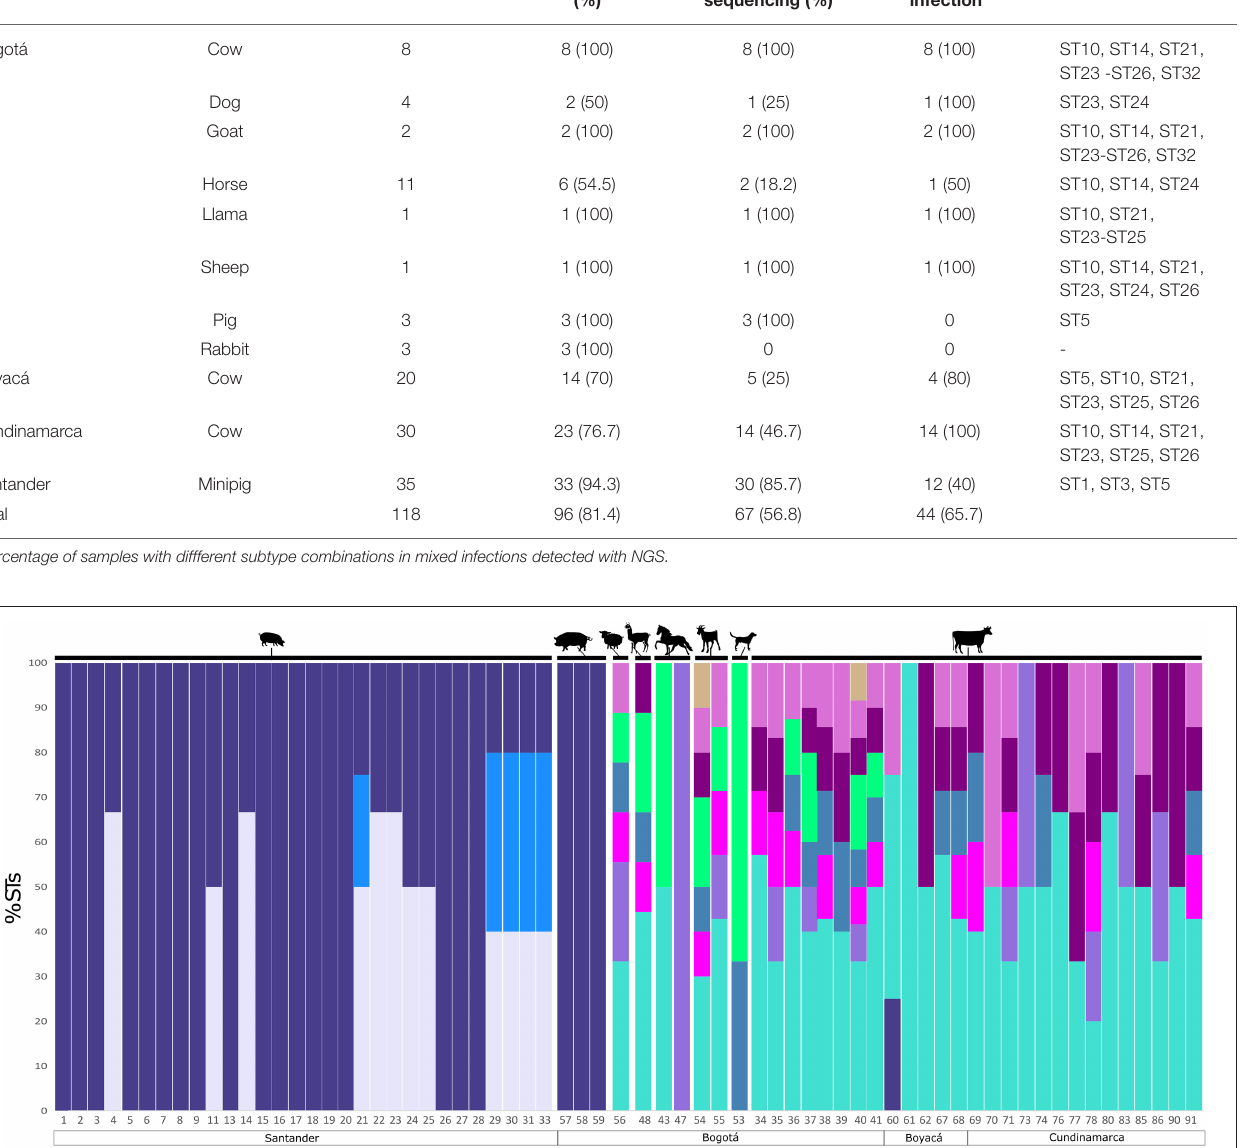
No. of positive No. of positive No. of samples Subtypes detected collected samples by PCR samples by with mixed (%) sequencing (%) infection*